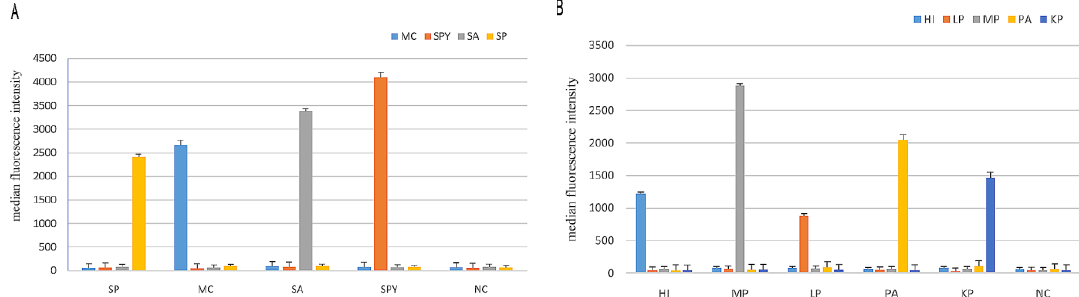
Figure 2. Results of the MPLT assay for nine target pathogens. ( A ) Detection of target products by the four-plex PCR-Luminex showed a high specificity. Distilled water was used as the negative control (NC). Each bar represents the average median fluorescence intensity (MFI) of triplicate samples. The error bars indicate standard deviations. SP, S. pneumoniae ; MC, M. catarrhalis ; SA, S. aureus ; SPY, S. pyogenes ; ( B ) Detection of target products by the five-plex PCR-Luminex showed a high specificity. Distilled water was used as the negative control (NC). Each bar represents the average MFI of triplicate samples. The error bars indicate standard deviations. HI, H. influenzae ; MP, M. pneumoniae ; LP, Legionella spp.; PA, P. aeruginosa ; KP, K. pneumonia .